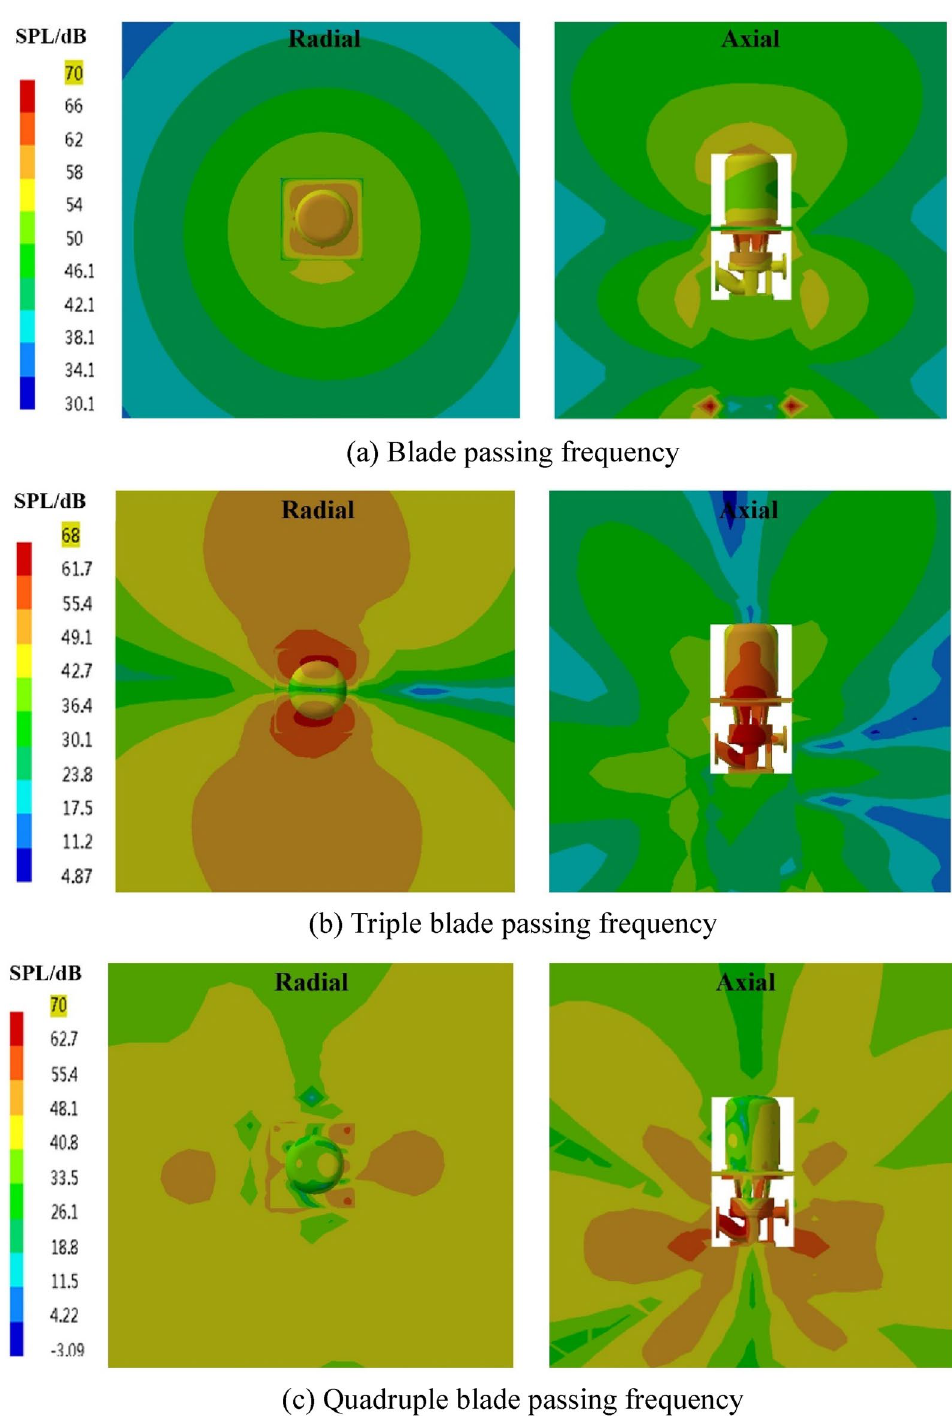
Figure 18. Pressure distribution of outfield noise by the surface